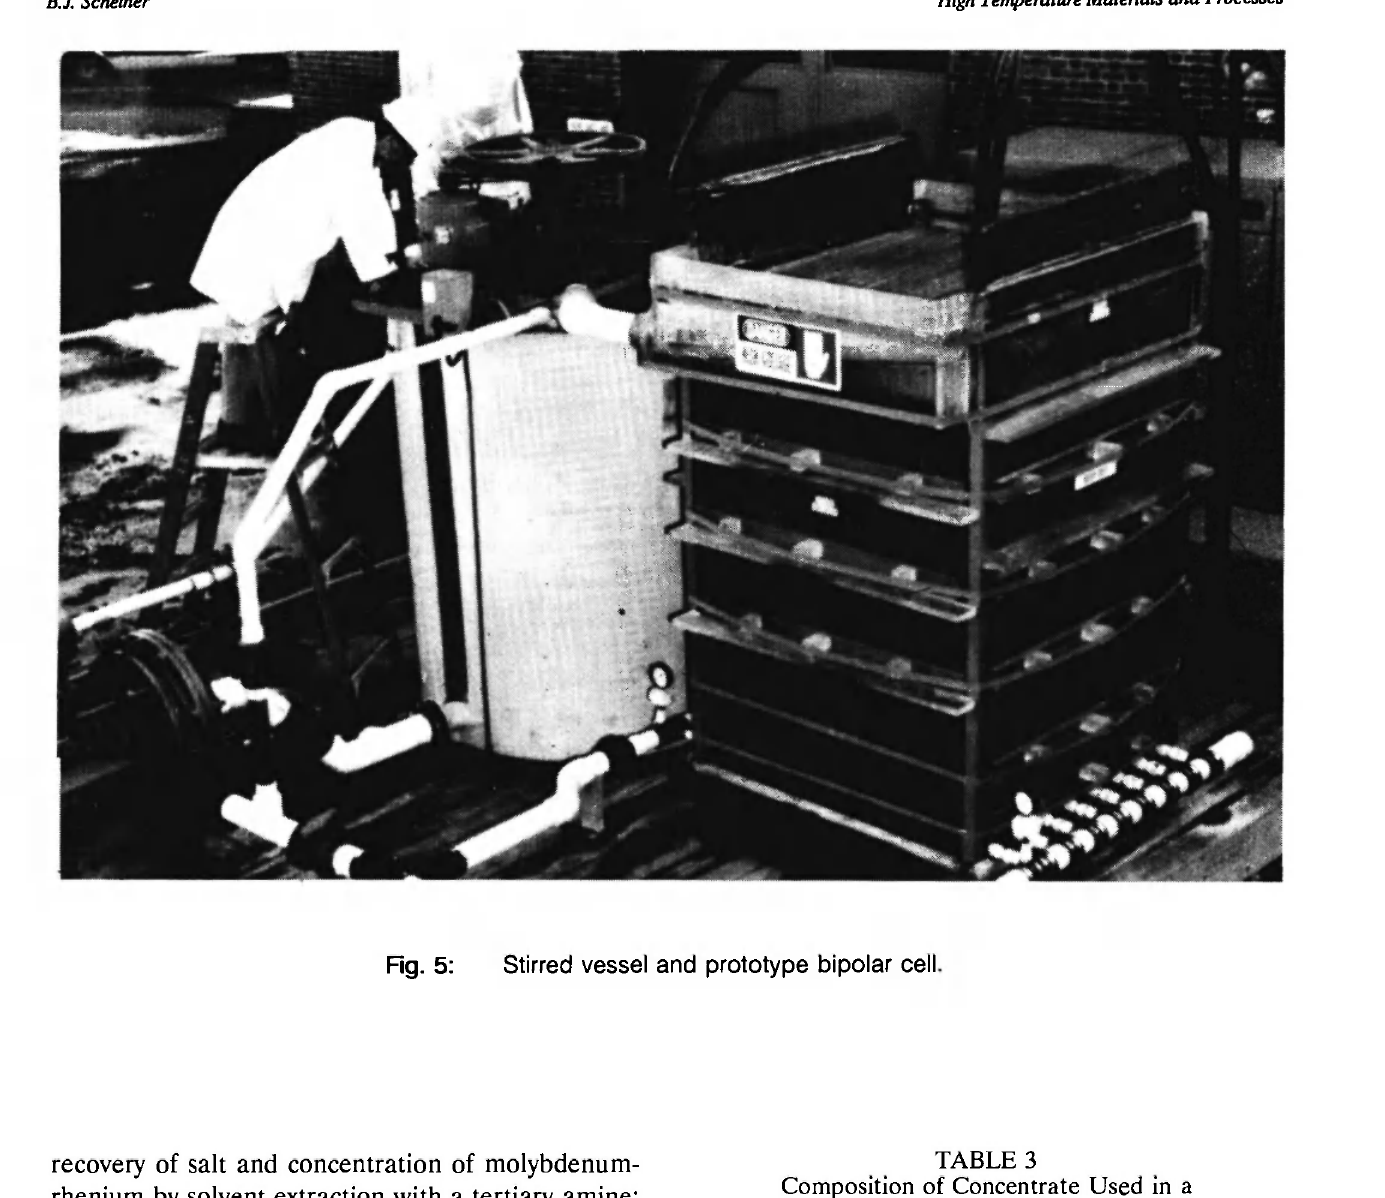
Fig. 5: Stirred vessel and prototype bipolar